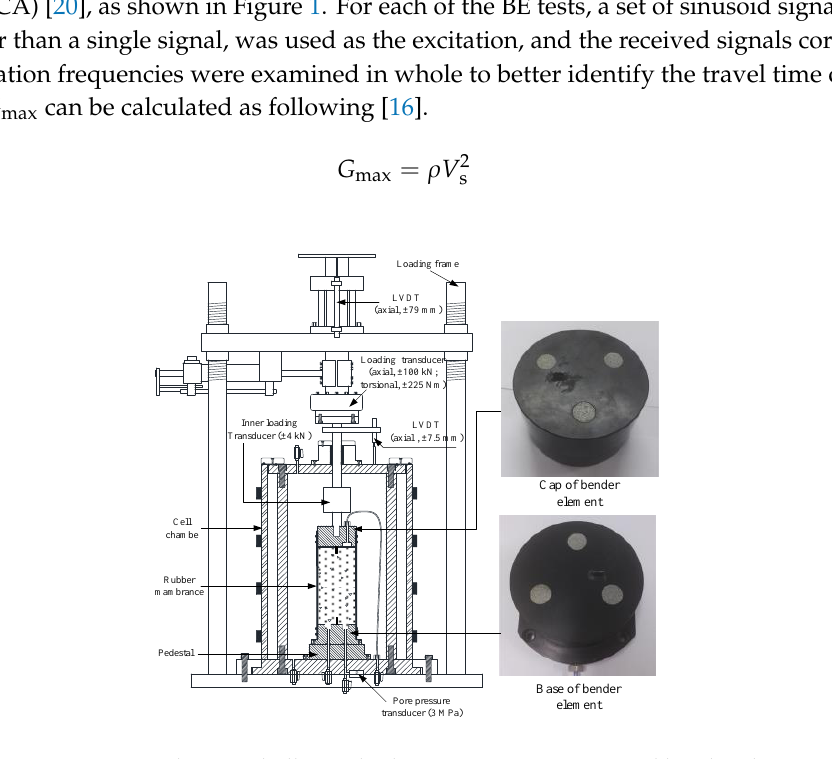
Figure 1. GCTS HCA-300 dynamic hollow cylinder-TSH testing system and bender element system.